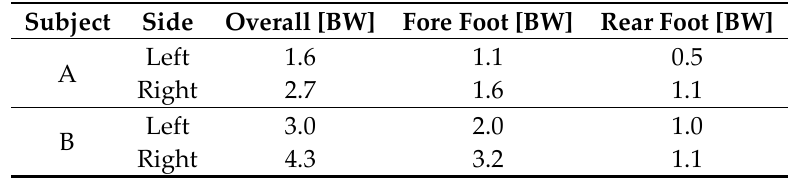
Table 1. Kinetic data of overall, fore and rear foot of one specific sample jump with low (subject A) and high (subject B) impact.